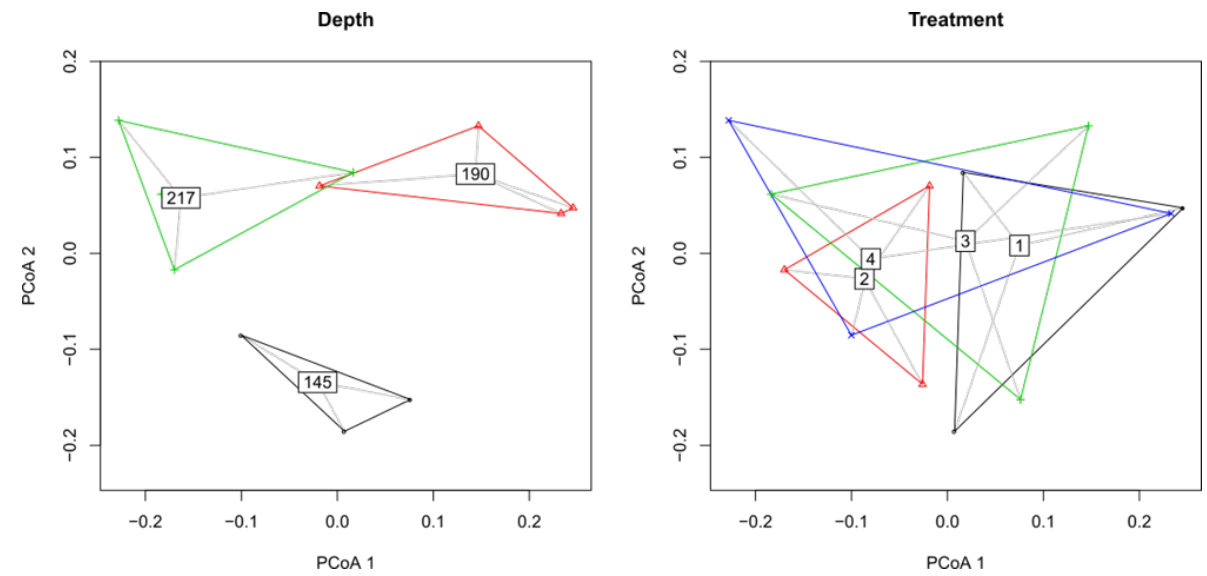
Figure 5. Principal coordinate analysis (PCoA), based on chord distance, among testate amoebae assemblages against depth and treatment.